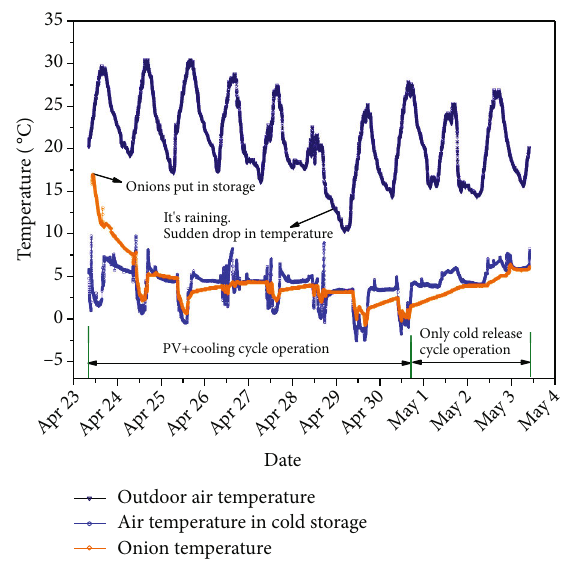
Figure 5: Variation of air temperature in the refrigerated warehouse, load temperature, and the ambient temperature outside cold